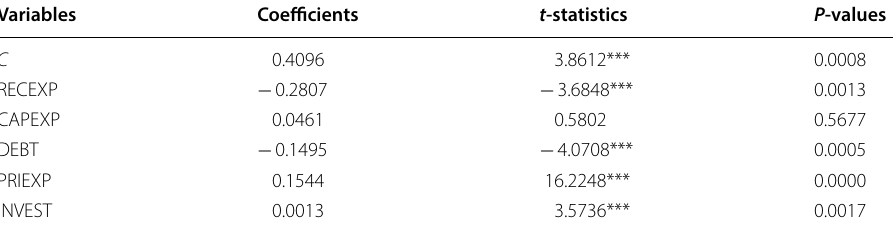
Table 3 Long-run